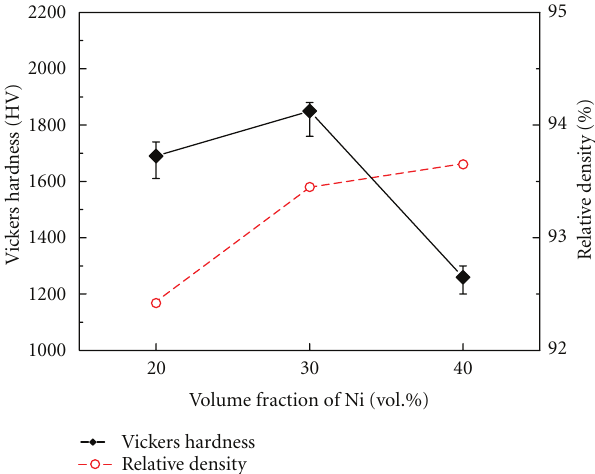
Figure 11: E ff ect of Ni volume fraction on relative density and Vickers hardness of samples with a TiC/TiB 2 ratio of